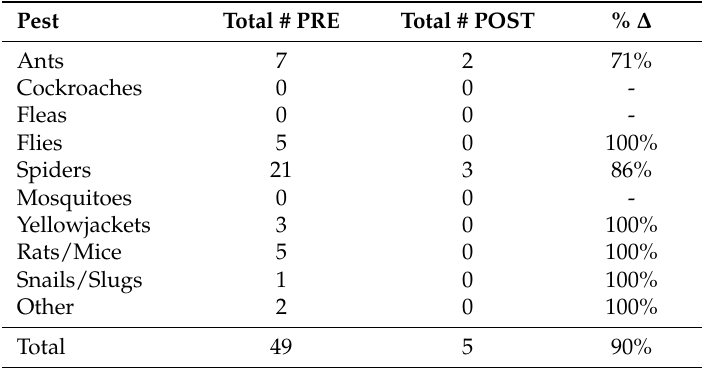
Table 6. Type and Number of Pests Observed During IPM Checklist